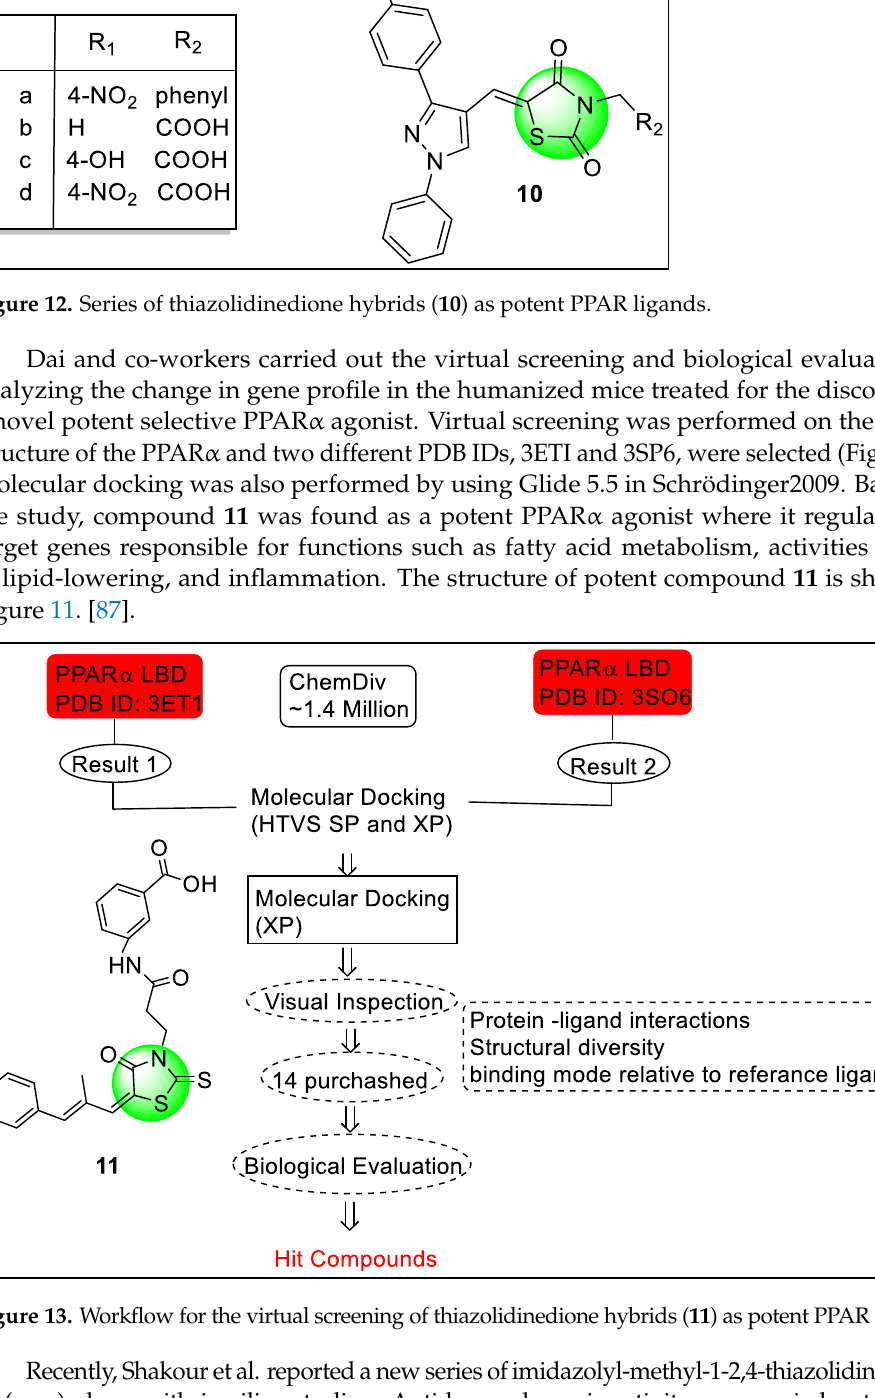
Figure 13. Workflow for the virtual screening of thiazolidinedione hybrids ( 11 ) as potent PPAR lig- ands.